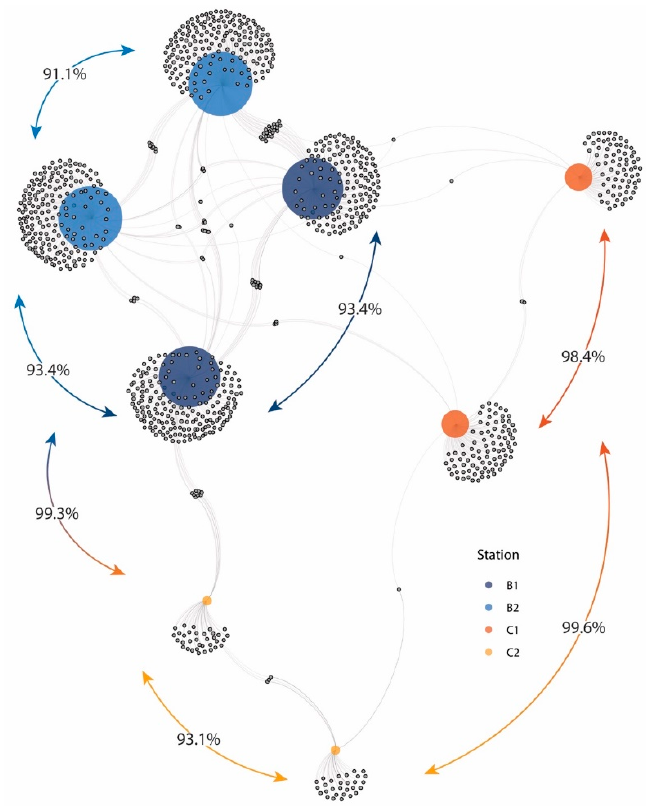
Figure 6. Network plot based on fungal assemblage composition found in the different sediment samples analyzed. Colored nodes represent sampling stations, while gray nodes represent the ASVs belonging to one or more samples to which are connected by gray edges. Arrows connecting samples indicate the Bray–Curtis dissimilarity calculated upon the log-transformed rarefied ASV